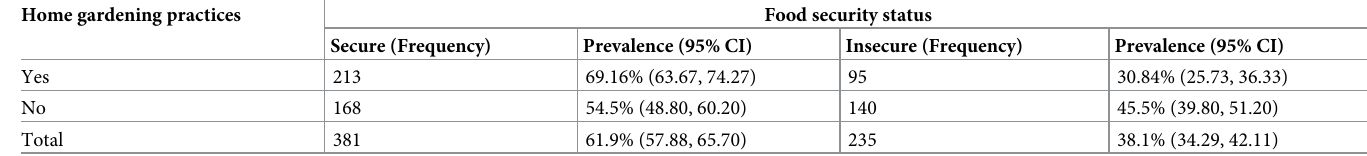
The overall prevalence of food insecurity in the study area found to be 38.1% (95%CI: 34.29, 42.11%). Comparing the two population groups, food insecurity found to be significantly higher in nonhome gardening groups than their counter parts with prevalence of 45.5% (95% CI: 39.80, 51.20%) (Table 2). Table 2. Level of food insecurity among home gardening and non-home gardening households in Zegie, Northwest Ethiopia, 2019. Home gardening